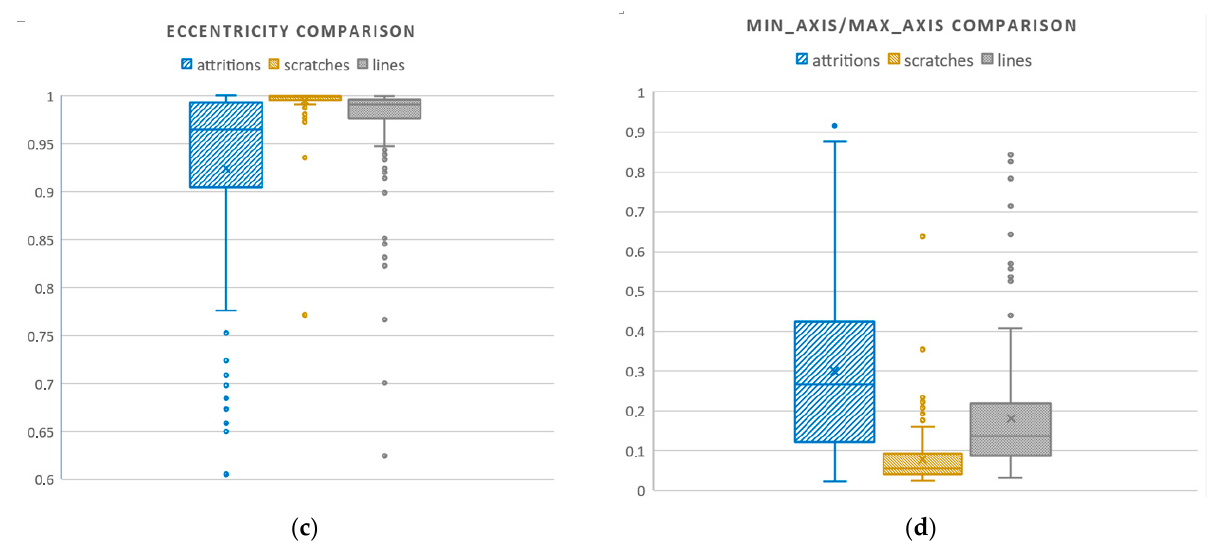
Figure 6. Box diagrams of defect types for the sample of images analyzed.